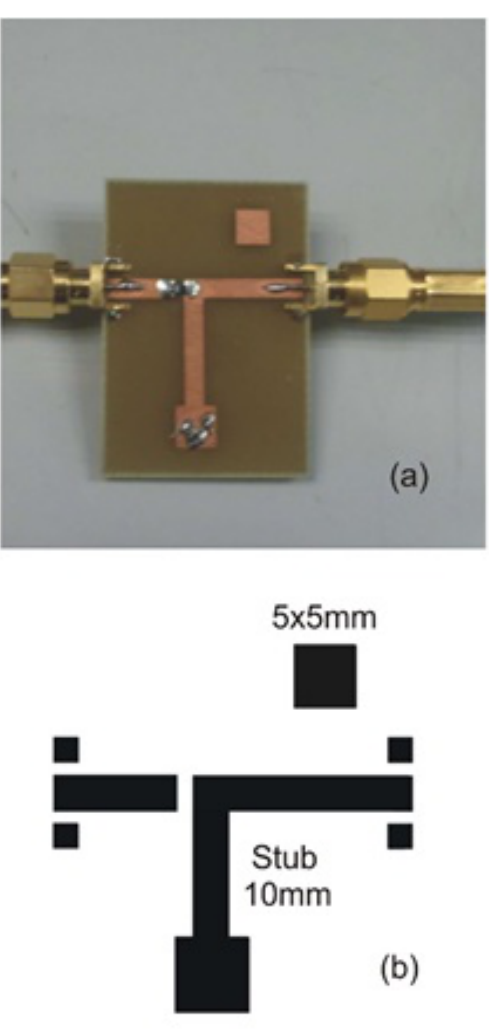
Figure 11: (a) Circuit and (b) Layout of Monocycle forming network.